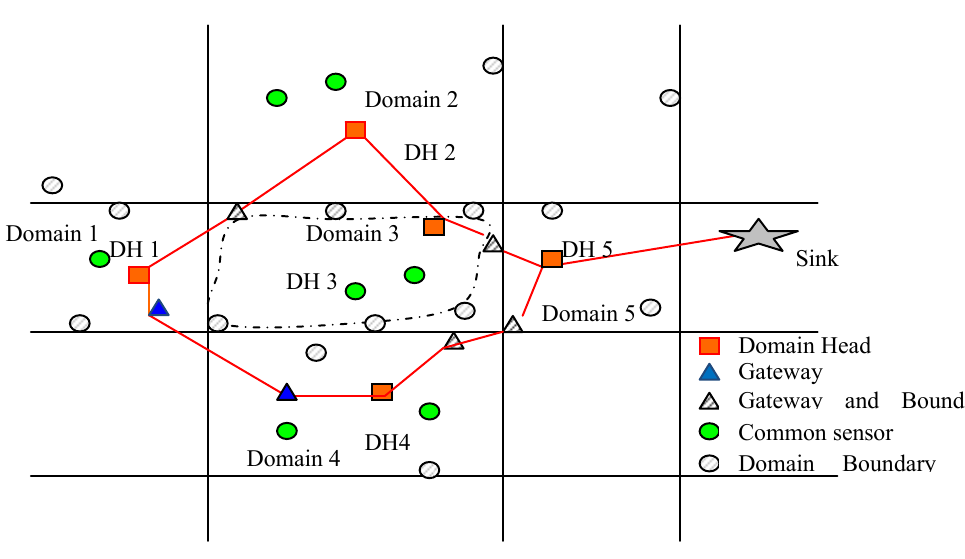
Figure 1. The connected core of sensor